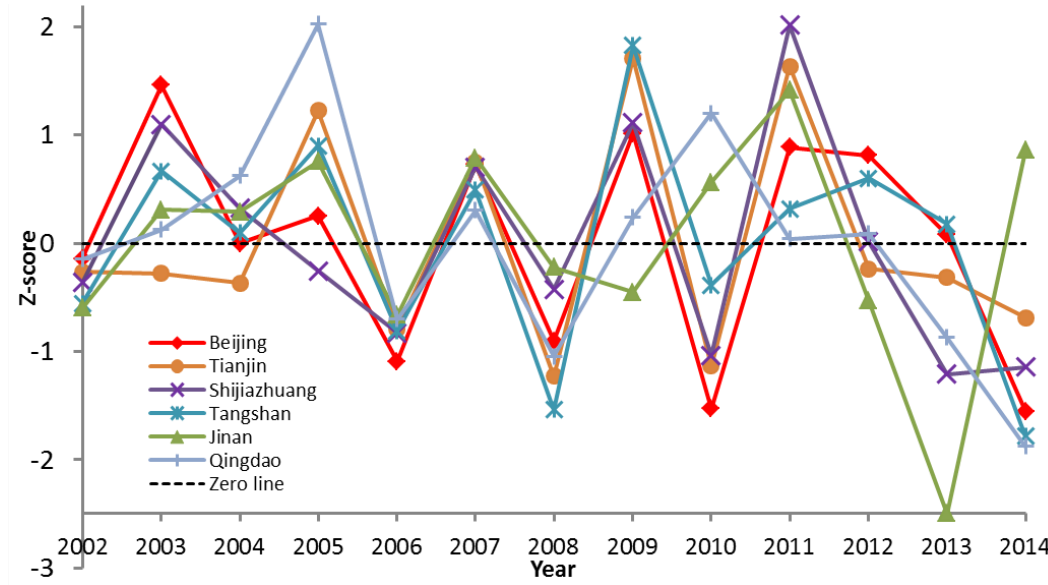
Figure 8. Z-score of mean MODIS AOT values during the APEC period (1–11